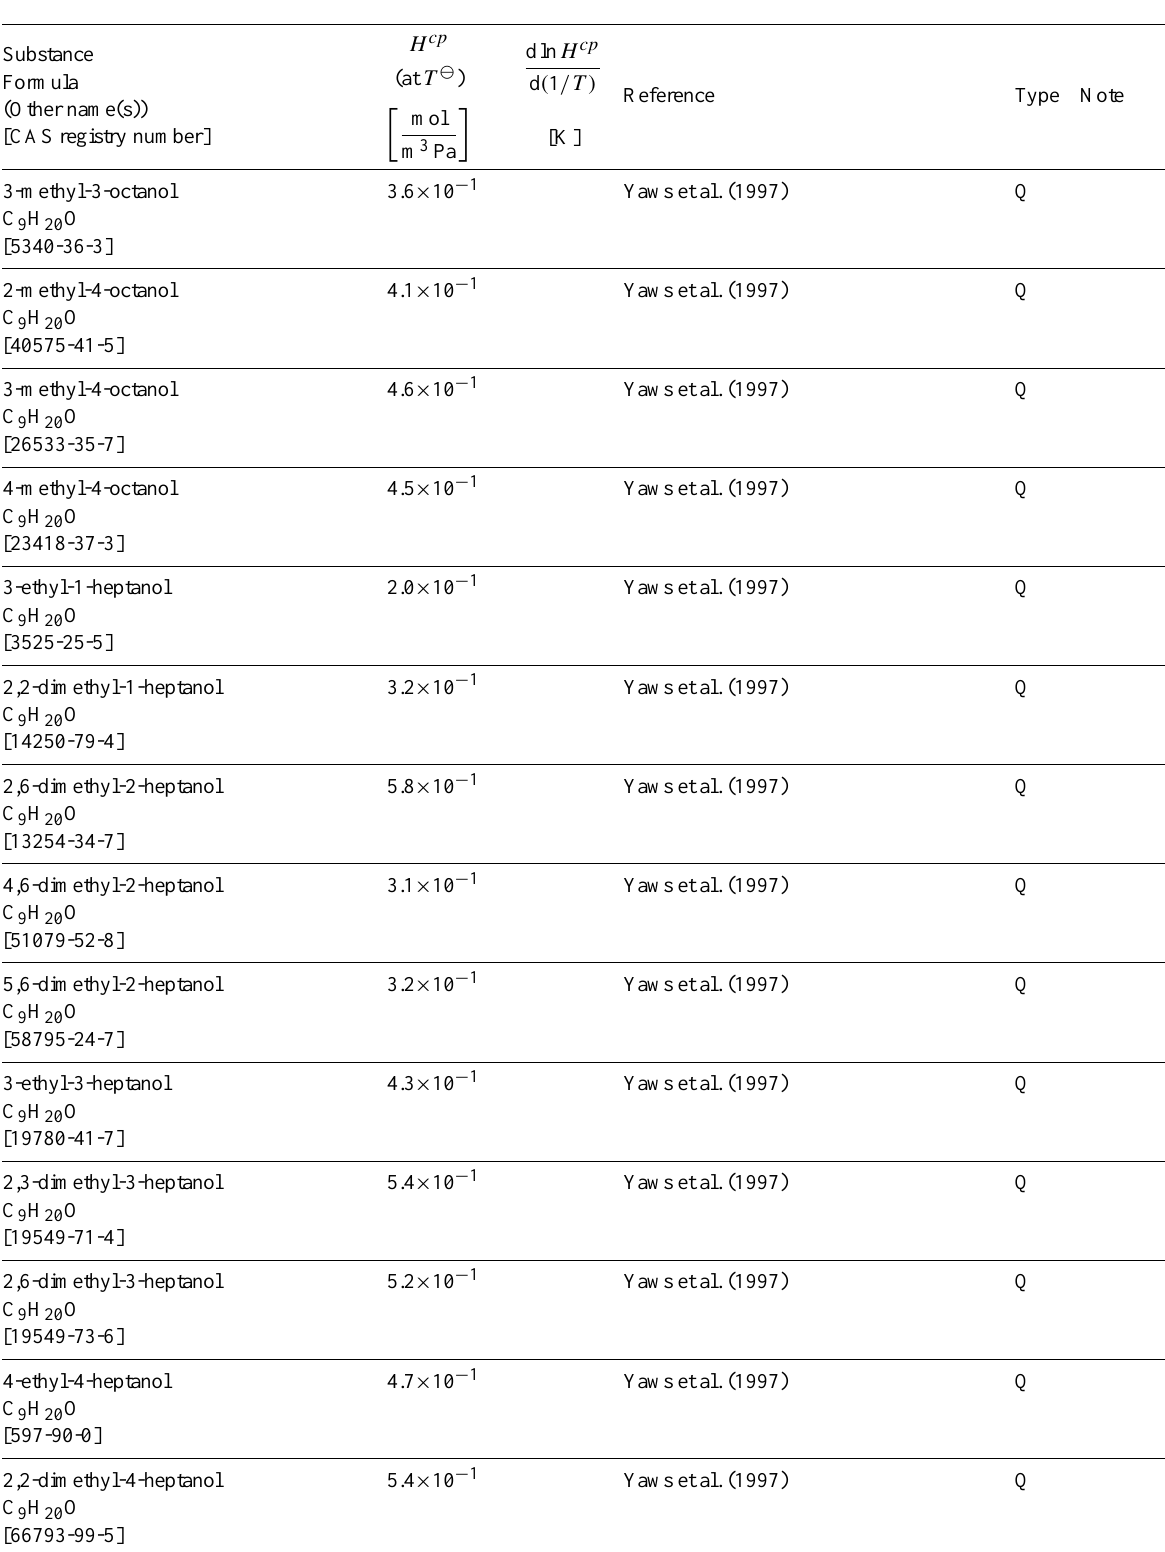
Table 6: Henry’s law constants for water as solvent